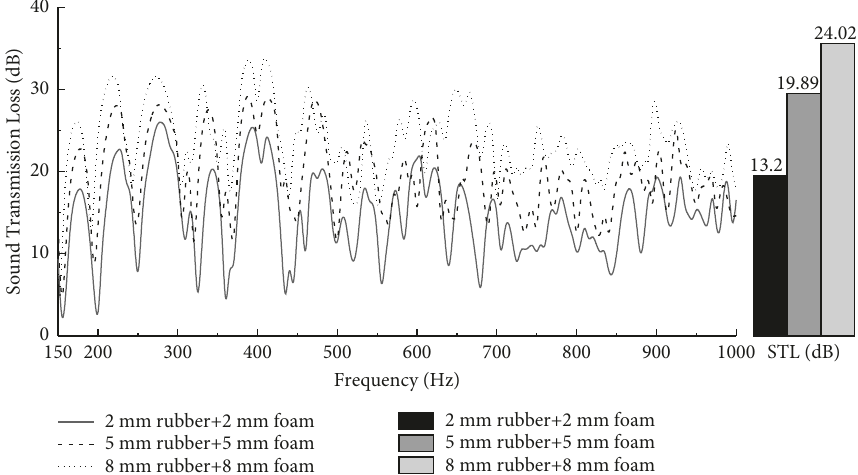
Figure 12: Comparison of different thicknesses of multilayer laying on the sound transmission loss of the cylindrical shell.